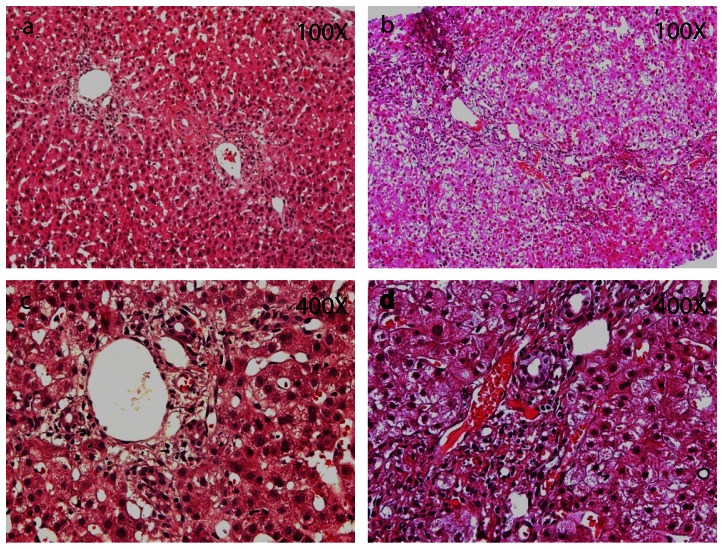
Liver biopsies from BC patients.Representative histopathology images of BC patients liver biopsies, A,C are from No-cryo group and B,D are from Cryo group. In the No-cryo group, the structure of hepatic lobule was integrated, normal hepatic plates were observed, hepatic cells occurred vacuolar degeneration, bile duct epithelium hyperplasia and a few inflammatory cells infiltration, cholestasis was seen (A, C). The integrity of the lobular structure was loss. Intrahepatic bile ducts proliferated significantly, part of the bile duct disappeared. Bile duct epithelial deformation, atrophy, shedding, ?the portal area shows infiltration of lymphocytes, the intrahepatic seen varying degrees of cholestasis, micro-thrombosis was observed in various sized portal area vessels (B, D).